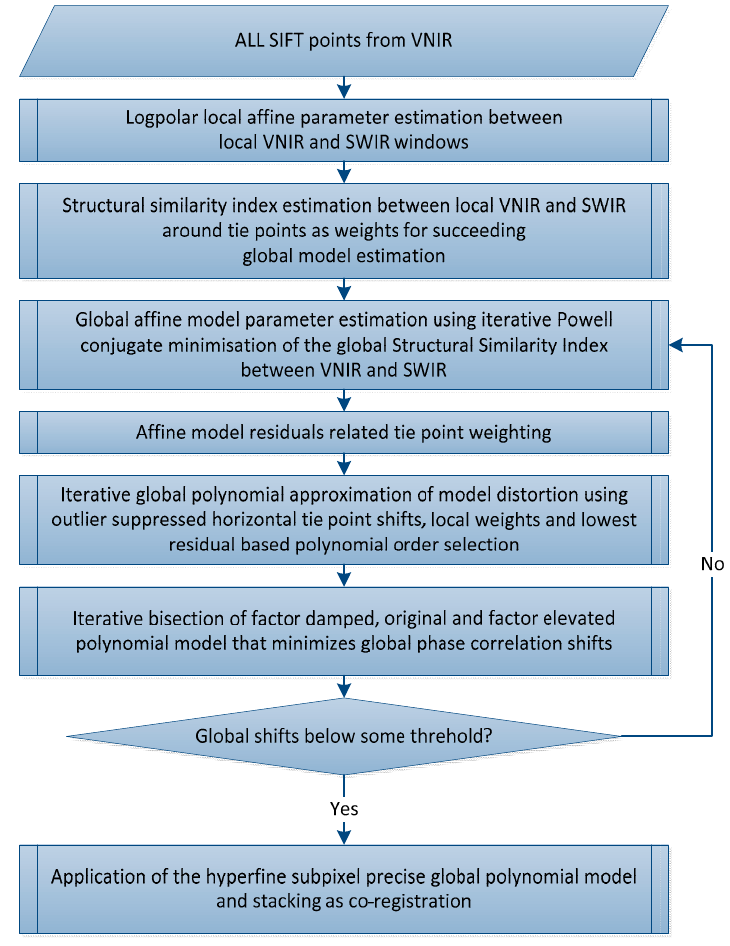
Figure 8. Scheme for hyperfine SIFT based logpolar warping.